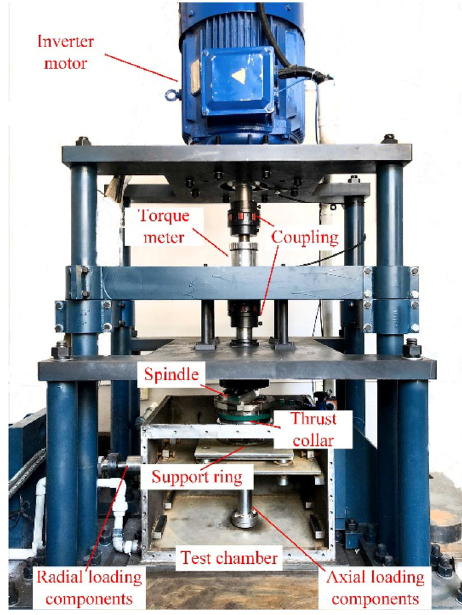
Fig. 18 Wear measuring system.